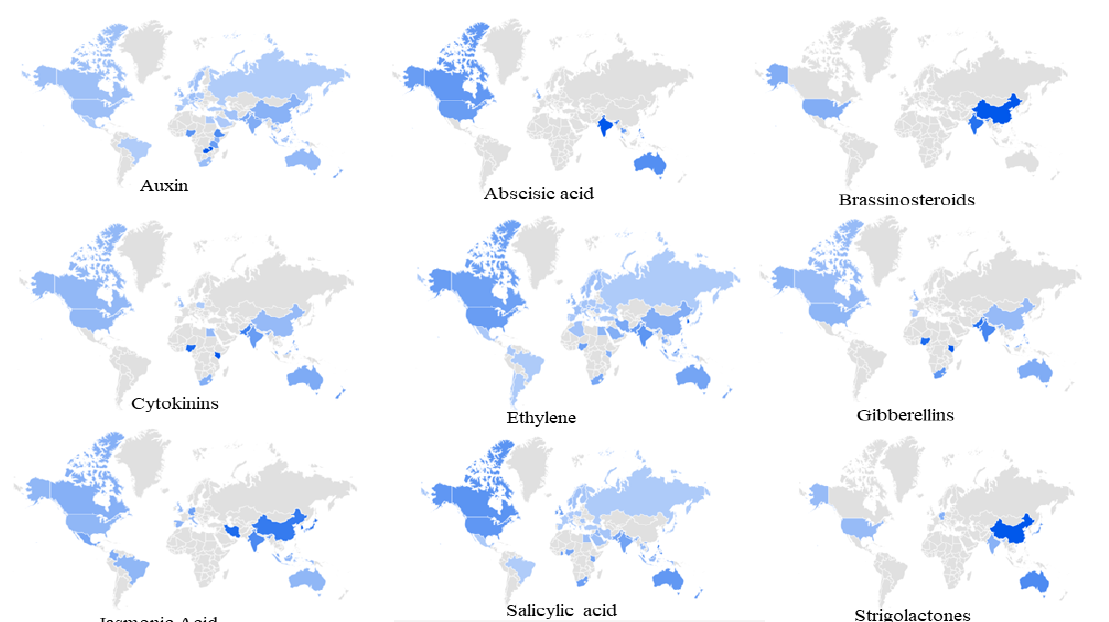
Figure 1. Global map of phytohormone search. The deep blue color indicates a high level of search query for the respective phytohormone, while the light blue color indicates a low search query. The map indicates data from 1 January 2004 to 20 October 2019.